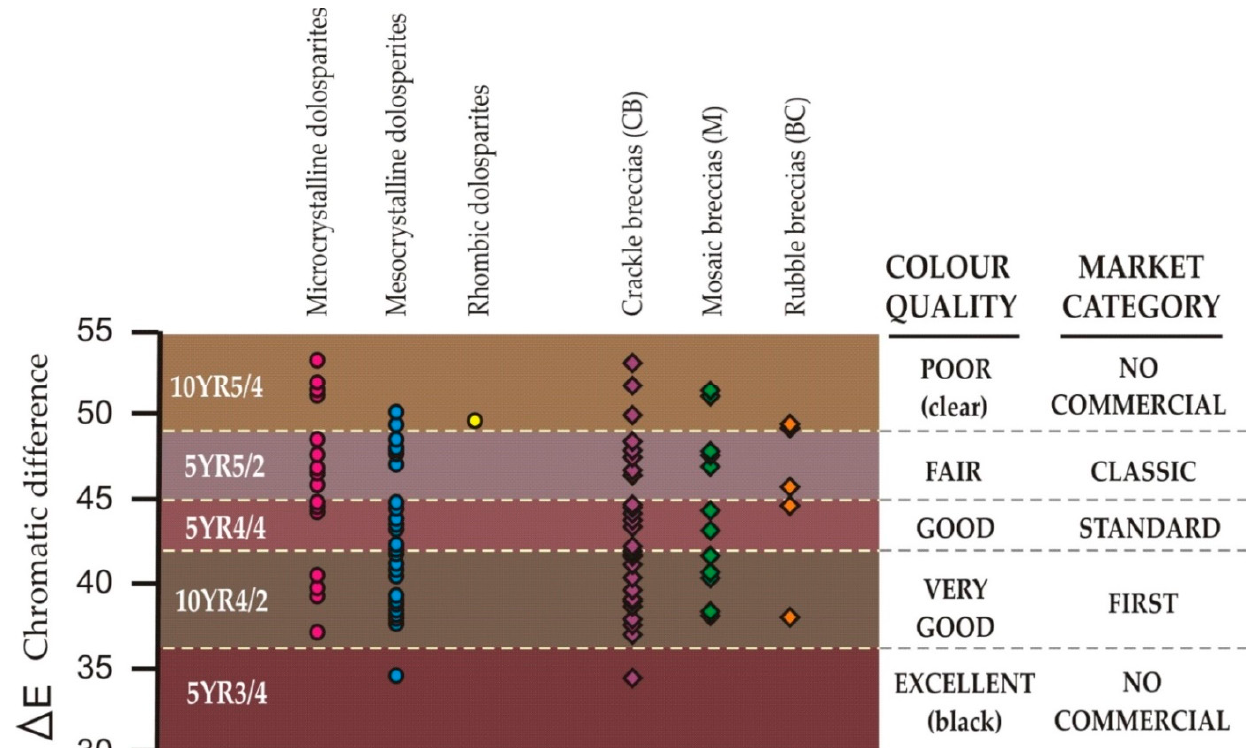
Figure 11. Chromatic characterisation of the Sierra del Cuchillo samples and chromatic classification.